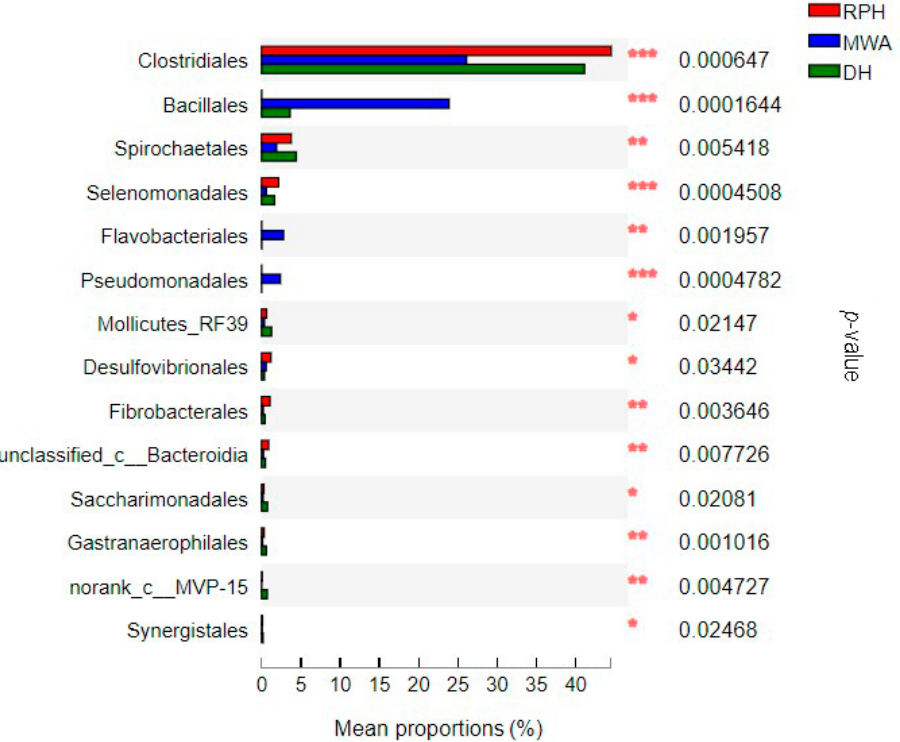
Figure 10. The bar plot shows the bacterial order with significant differences among RPH, DH and MWA. * p < 0.05, ** p < 0.01 and *** p < 0.001. Furthermore, a total of 116 families were found in all samples. The top four families with relative abundance at 1 order of magnitude in RPHs were Lachnospiraceae (23.12%), Ruminococcaceae (16.90%), p-251-o5 (15.52%) and Rikenellaceae (10.56%). For the wild ani- mal group, DHs were lower in all families except for Rikenellaceae , while the others were higher in DHs and MWAs (Supplementary Table S5). The top family in MWAs was Plano- coccaceae, which showed relative abundance of 23.55%, but Planococcaceae had only 0.058%, 0.065% and 3.76% in CPHs, RPHs and DHs, respectively (Supplementary Table S5). The Wilcoxon rank-sum test showed that families of Rikenellaceae and Bacteroidales _UCG-001 had significant differences between CPHs and RPHs (Figure 11). The Kruskal–Wallis H test showed that the family of Planococcaceae had significant differences among the RPHs, DHs and MWAs (Figure 12).